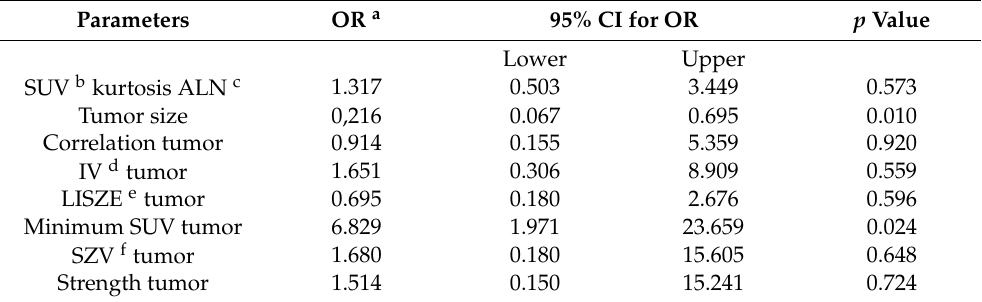
Table 5. Multivariate regression analysis of the clinical and textural parameters for the prediction of pathologic complete